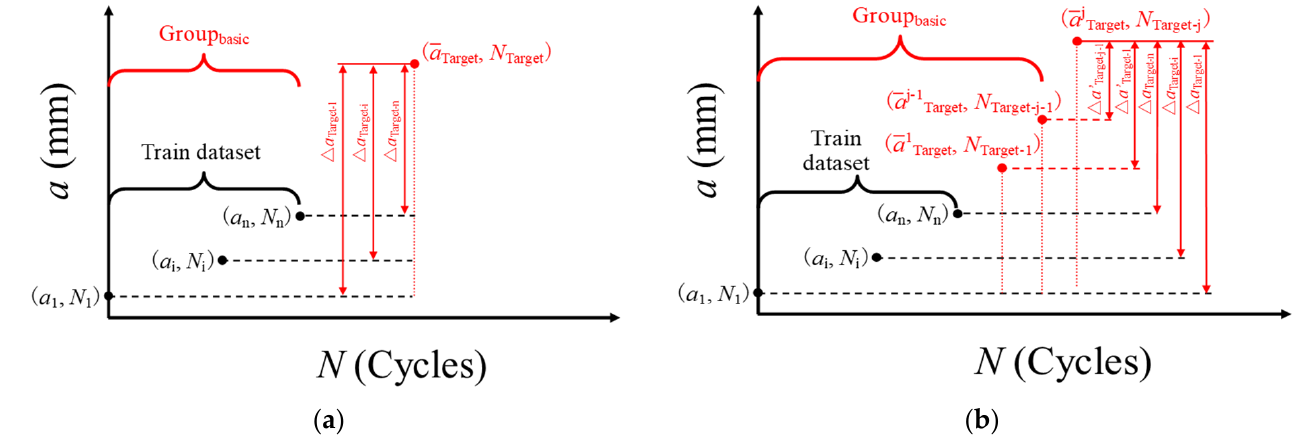
Figure 12. The way to construct dataset during testing process: ( a ) Unmove way (Group basic = Train dataset) and ( b ) Move way (Group basic > Train